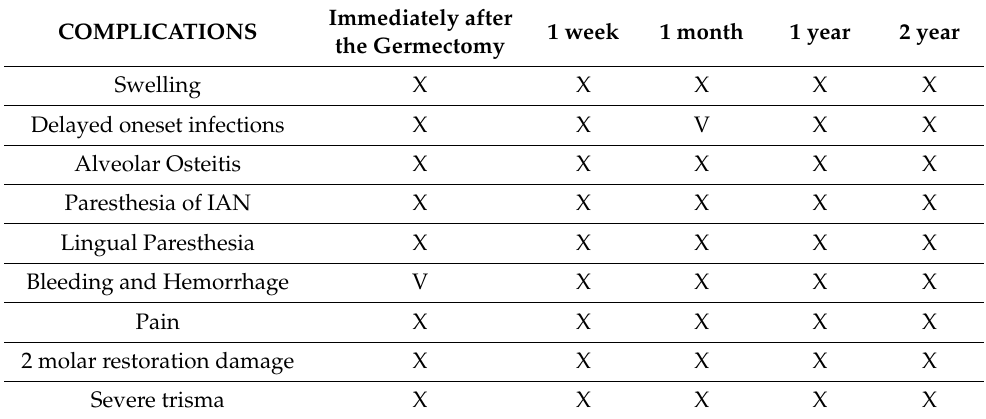
Table 3. Complications observed during the various checks following the surgery.